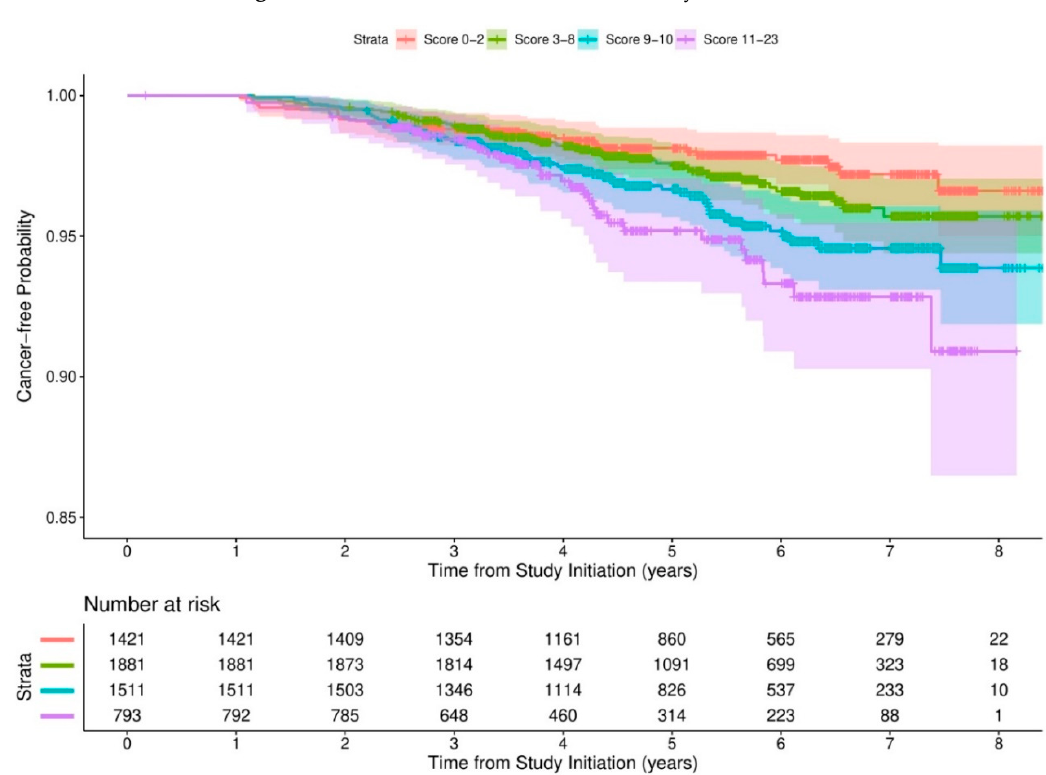
Figure A2. Kaplan–Meier estimates of cancer-free probability by comorbidity risk scores after removing total cholesterol from comorbidity risk score.